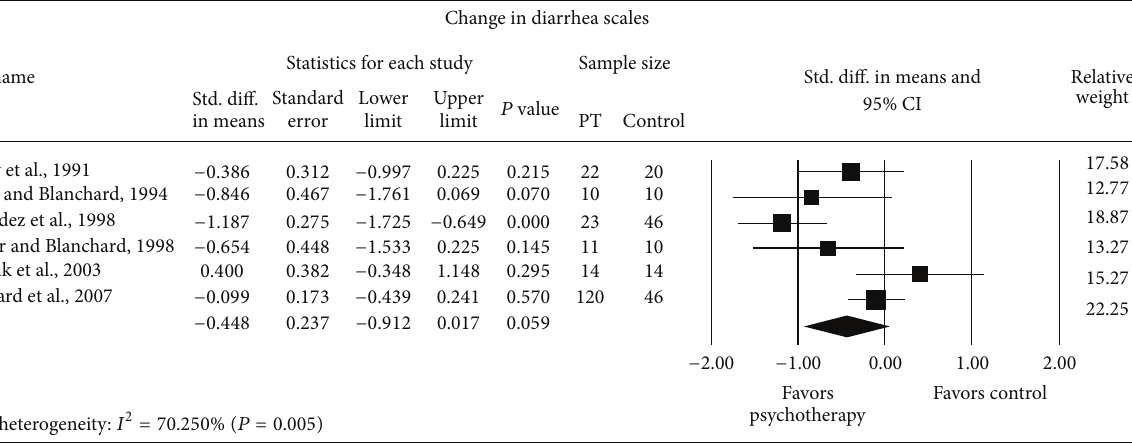
Figure 5: Forest plot for diarrhea scales in RCTs of psychotherapy (PT) versus